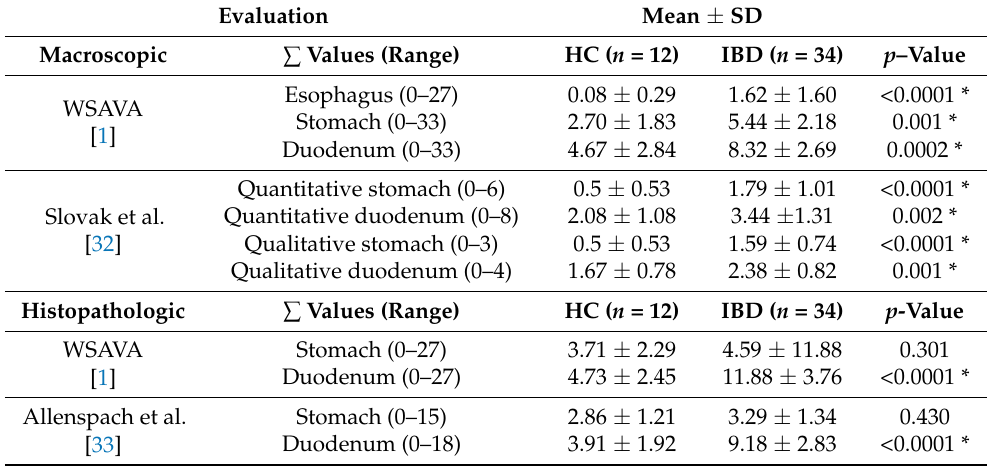
Table 2. Comparison of macroscopic and histological findings using different scores in the dogs enrolled in the